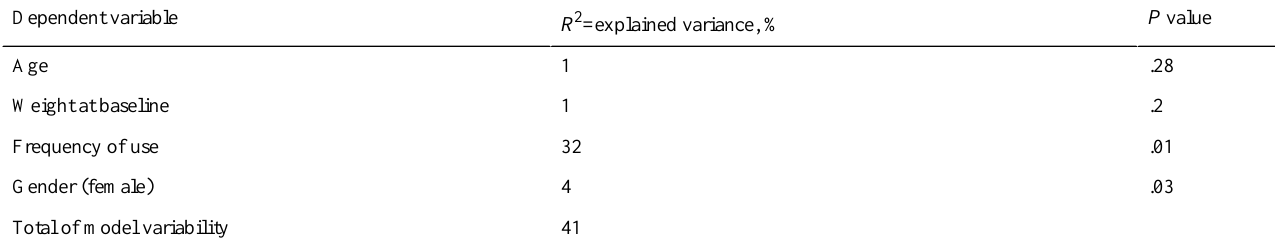
Table 5. Linear regression model presenting success